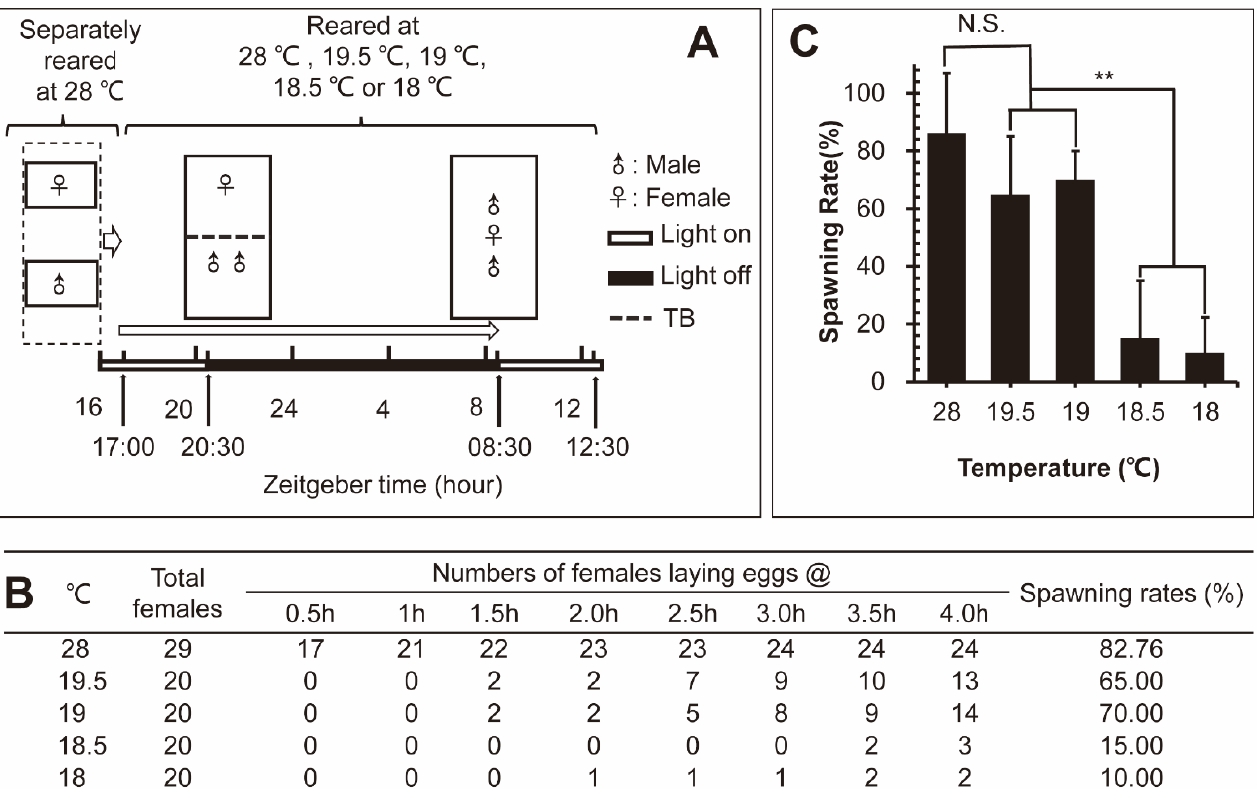
Figure 1. The fecundity of the zebrafish at different temperatures. ( A ) The schematic diagram for the fecundity of the zebrafish experimental process. (TB: transparent baffle). ( B ) The number of spawning zebrafish increased over time and spawning rates of female zebrafish at different temperatures. ( C ) Comparison of female spawning rates at different temperatures. (** p < 0.01; N.S.: no significance).